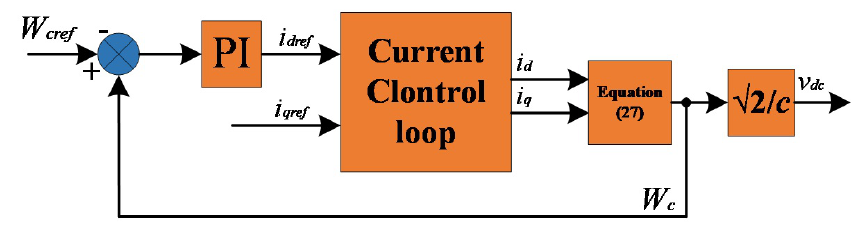
Figure 9. Capacitor energy as a variable control